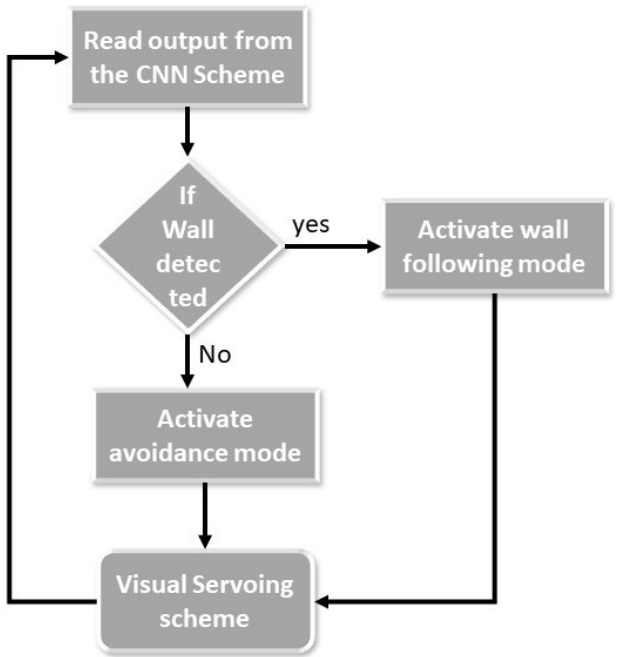
Figure 5. Operational Flow Diagram.